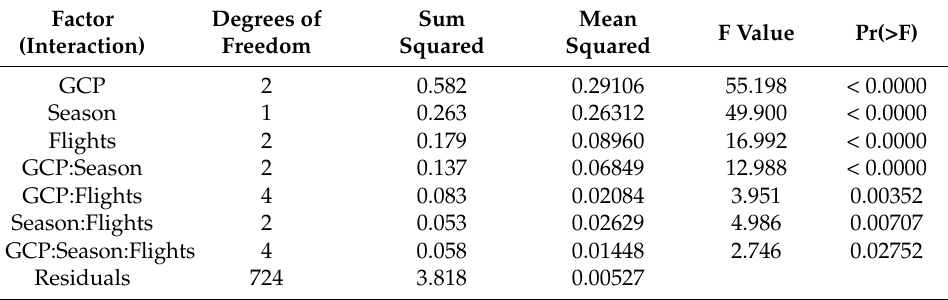
Table 9. Results of the three way factorial ANOVA for horizontal accuracy. Evaluated factors: georectification method (GCP), flight pattern, vegetation season; and their interactions.